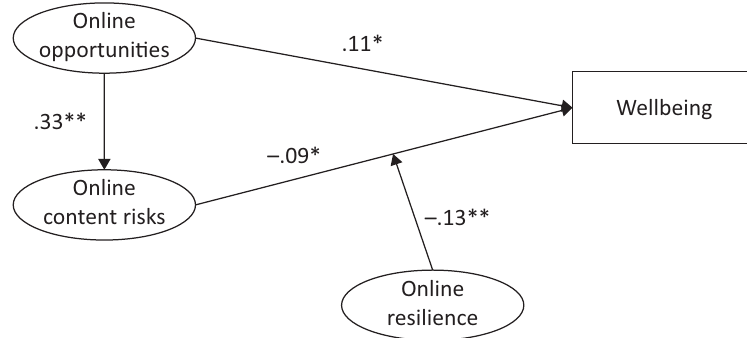
Figure 1. Path model for online opportunities, online content risks, online resilience, and wellbeing. Notes: For clarity, the measurement model is not pictured and the control variables are not included in this figure. Results that include the control variables and unstandardized coefficients can be found in Table 1. Note: * p < .05, ** p < .01.